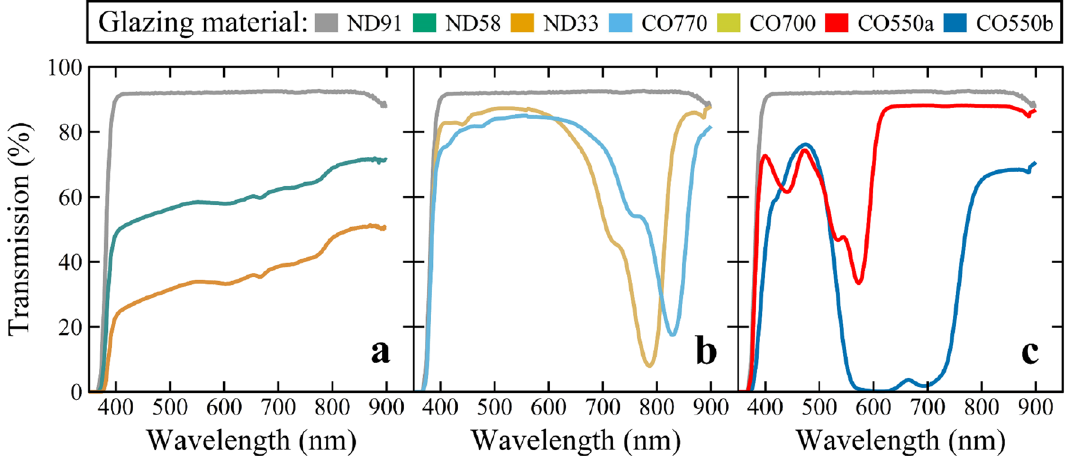
Figure 2. Transmitted photon spectra of glazing materials. Measurements were made inside chambers covered with various glazing materials with different spectral transmissions on a clear day around solar noon. ( a ) ND91 (91% transmission) (repeated in b and c ), ND58 (58% transmission), and ND33 (33% transmission) were acrylic sheets with different photon transmissions. ( b ) CO770, CO700, and ( c ) CO550a, and CO550b were experimental photoselective glazing materials with different wavelength transmission cutoffs in the photosynthetically active radiation (PAR; photons between 400 and 700 nm) and the near-infrared (NIR)